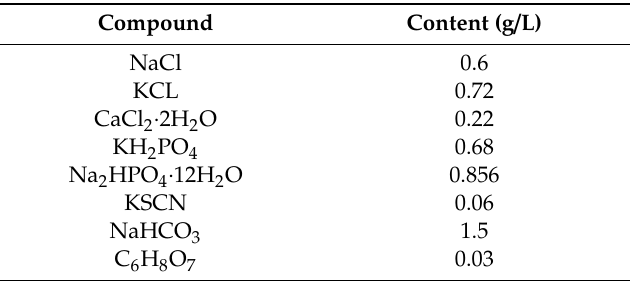
Table2. Chemicalcompositionofartificialsaliva(pH = 6.5)usedtorecreatethebiochemicalenvironment of human saliva.